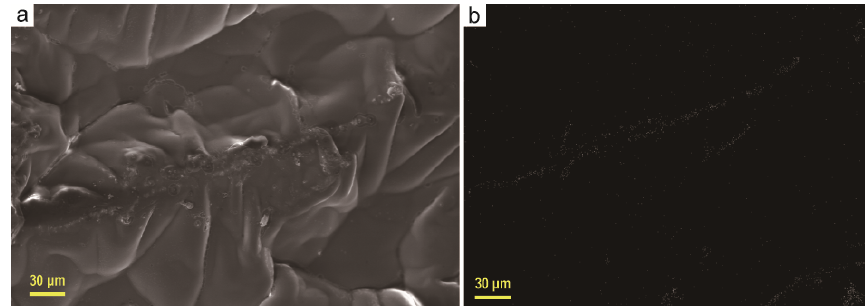
Figure 4. SEM image of PArGO ( a ) and EDS images of silver elemental plane scans ( b ).